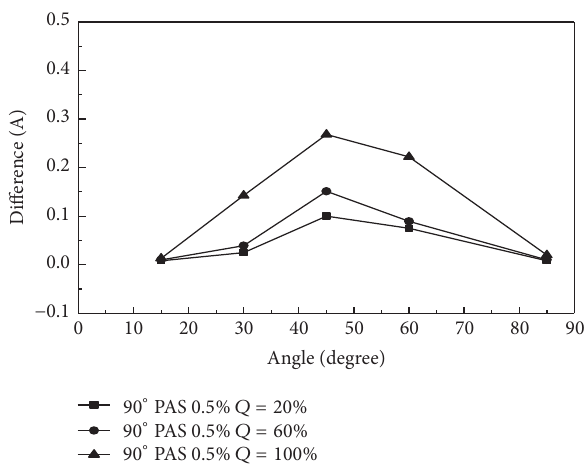
Figure 20: The PAS angle of curved tube: difference diagram of various flows in 90 ∘ curved tube.